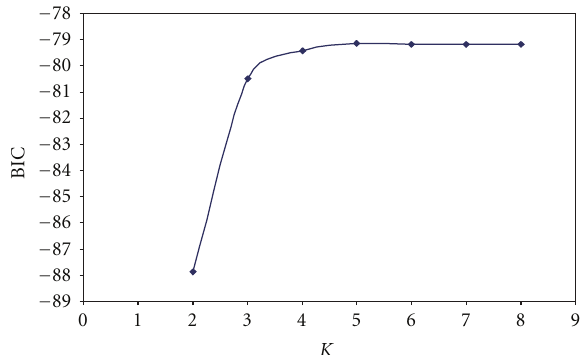
Figure 3: Plot of BIC values for isotropic phantom data set, scaled by a factor of 1000.